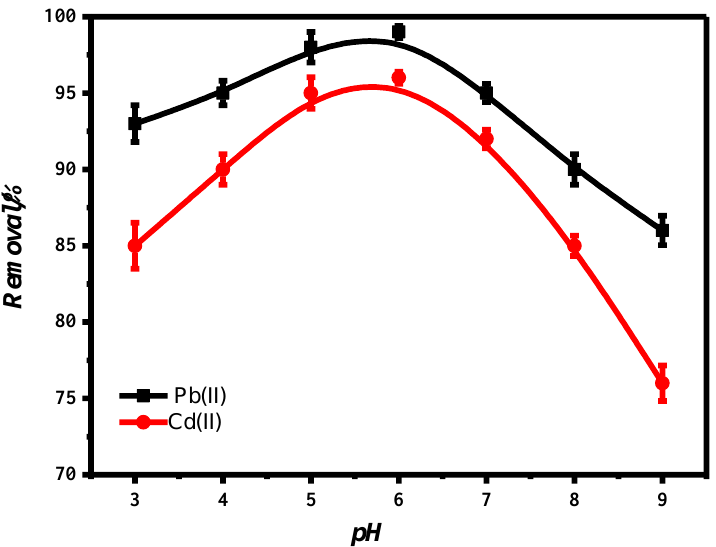
Figure 7. Removal percentage of Pb 2+ and Cd 2+ adsorbed onto BI@MWCNTs at different pH solutions of metal salt solution (C 0 : 100 mg/L; dosage of adsorbent: 0.2 mg/mL; temperature: 25 ◦ C; time: 30 min; volume: 50 mL).